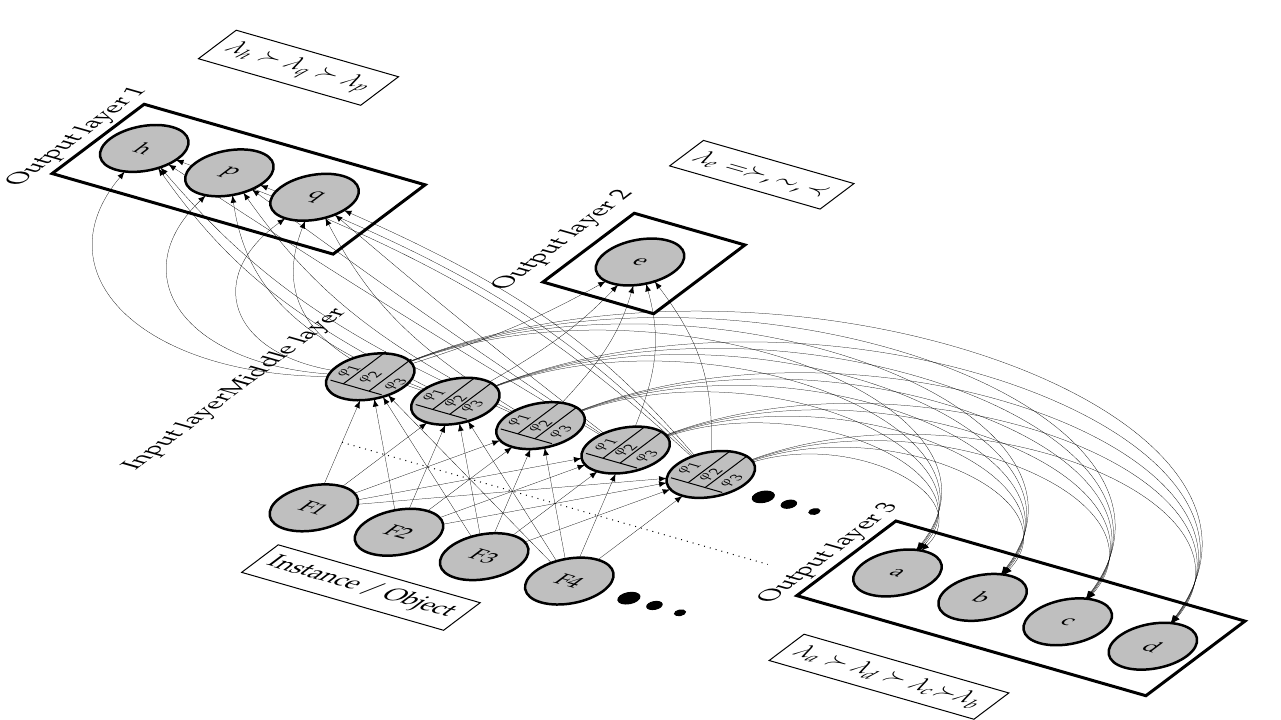
Figure 8. Three subgroups architecture SGPNN used in ranking emotions dataset where ϕ 1 n = 4 , ϕ 2 n = 3 , ϕ 3 n = 3 , and f in = 4. the second subgroup is represented by one node that has 3 values (1, 2, and 3) mapped to preference relations λ e = (cid:31) , ∼ , ≺